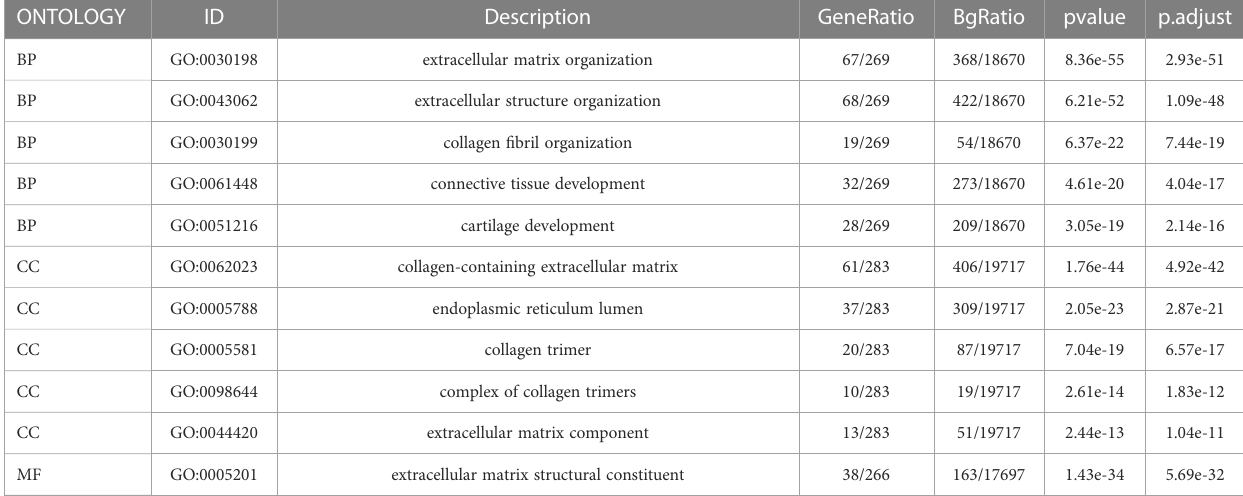
TABLE 1 Gene Ontology (GO) analyses of the top 300 co-expression genes positively associated with TPM4 expression.